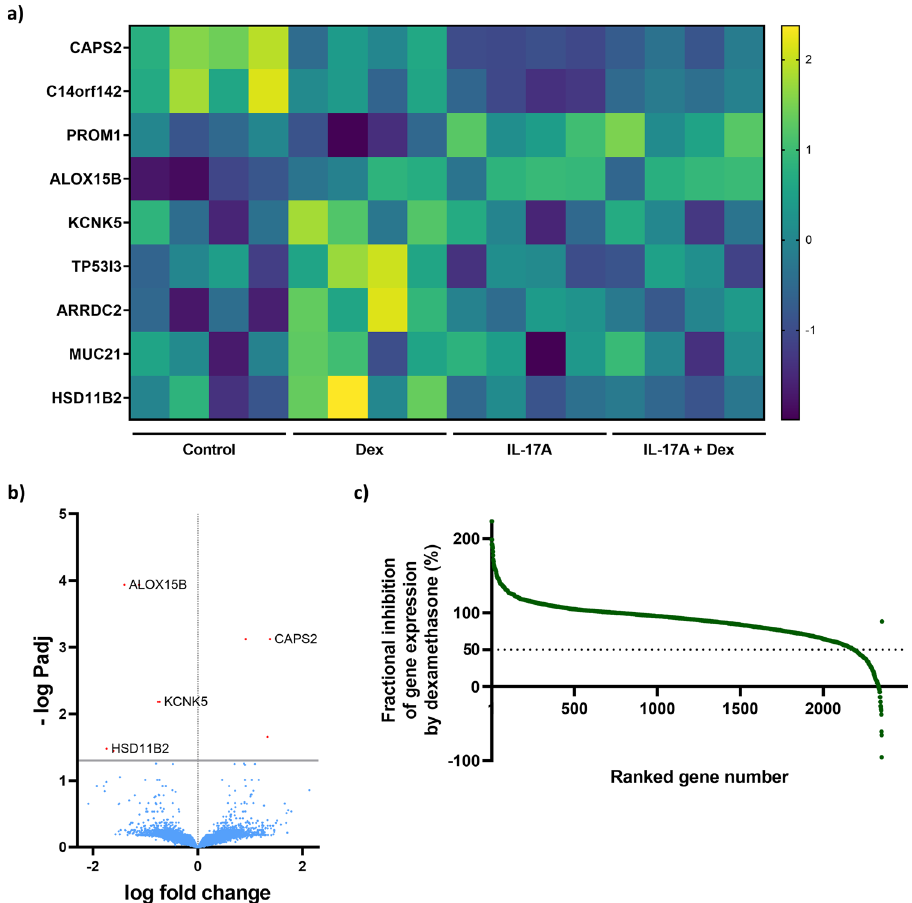
Figure 4. IL-17A and Dexamethasone (Dex) interaction in human airway epithelial cells (hAECs). hAECs were cultured and differentiated at an air liquid interface (ALI) and exposed to IL-17A (10 ng/ml) with or without dexamethasone (10 nM) for 14 days. Gene expression was determined by bulk RNA sequencing and differentially expressed genes were analyzed. 9 genes showed significantly interaction by IL-17A and dexamethasone and are presented in a heatmap, with each column in the groups representing an individual donor ( a ) and by a volcano plot ( b ). Genes that were differentially expressed by at least 1.5-fold response to IL-17A stimulation were included in the analysis and for these genes, the ability of dexamethasone to reverse this gene expression was assessed. The resulting score was normalized to 100%, yielding genes with a score of 100% as being completely dexamethasone resistant and genes with a score of 0% as being completely dexamethasone sensitive ( c ). N = 4